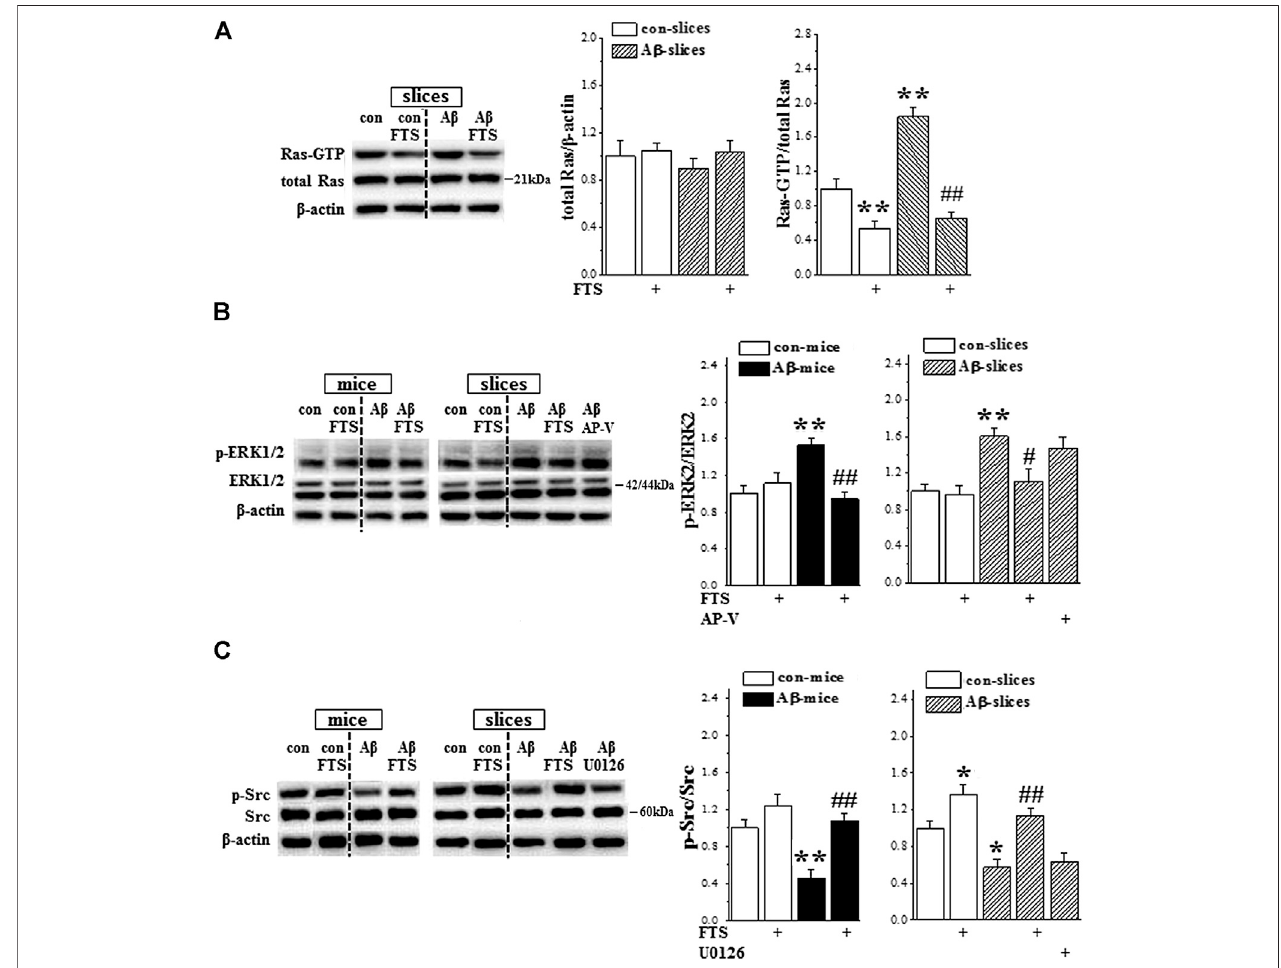
FIGURE 4 | A β 1-42 -activated Ras enhances ERK signaling and suppresses Src activity. (A) Acute effect of A β 1-42 on hippocampal Ras activity. Left panels show representative pictures ofWestern blot in control slices (con), FTS-slices (FTS), A β 1-42 -slices (A β ) and A β 1-42 /FTS-slices (A β /FTS). Bar graphs represent the levels ofRas protein and Ras-GTP. The mean value per experimental group was normalized by control. ** p < 0.01 vs. control slices; ## p < 0.01 vs. A β 1-42 -slices (two-way ANOVA, n (cid:1) 12 per group). (B) and (C) Bar graphs show the levels of hippocampal ERK2 and Src phosphorylation ( p -ERK2, p -Src) in control mice/slices (con), FTS-mice/ slices (FTS), A β 1-42 -mice/slices (A β ) and A β 1-42 /FTS-mice/slices (A β /FTS). * p < 0.05 and ** p < 0.01 vs. control mice/slices; # p < 0.05 and ## p < 0.01 vs. A β 1-42 -mice/ slices (two-way ANOVA, n (cid:1) 6 mice or 12 slices per group).